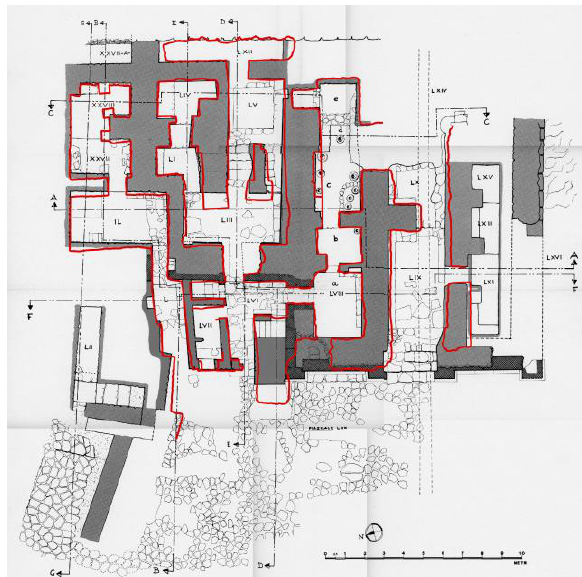
Figure 10. Overlap between the old plan and the one obtained from the photogrammetric model (red line)